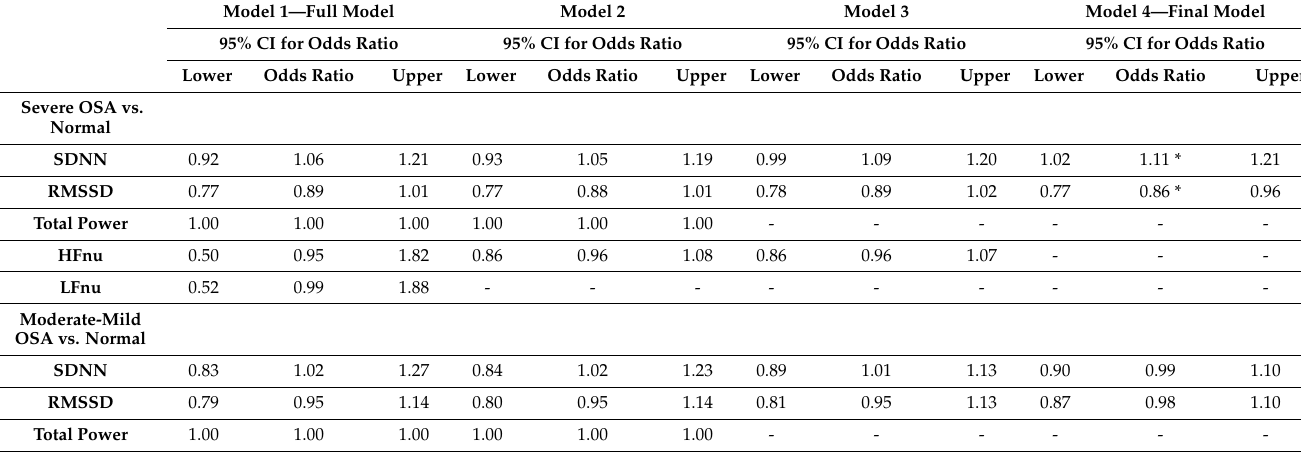
Table 1. Multinomial logistic regression models (backward stepwise) with “Normal” as the reference